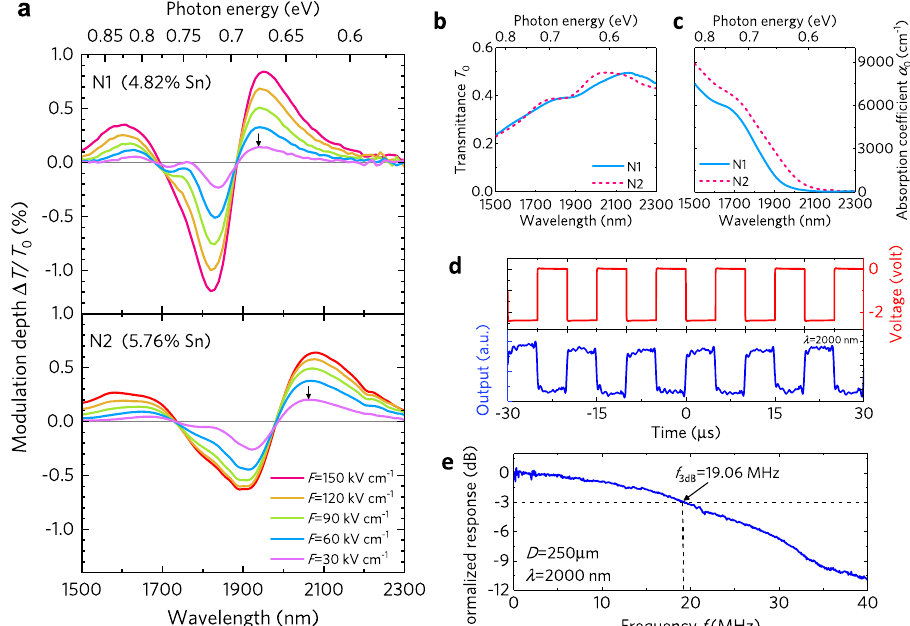
Fig. 3 Modulation characteristics at room temperature. a Modulation depth spectra of the GeSn devices measured at different electric fi elds. Clear variations in transmittance are observed, providing strong evidence of the Franz – Keldysh effect. The lowest direct transition energies are indicated by the solid black arrows. b Transmittance spectra for the GeSn devices and c absorption spectra under zero-bias conditions for the GeSn active layers. d Applied AC bias voltage (upper panel) and AC optical modulation signal (lower panel) at 100 kHz at λ = 2000 nm for device N1. e Normalized radio frequency